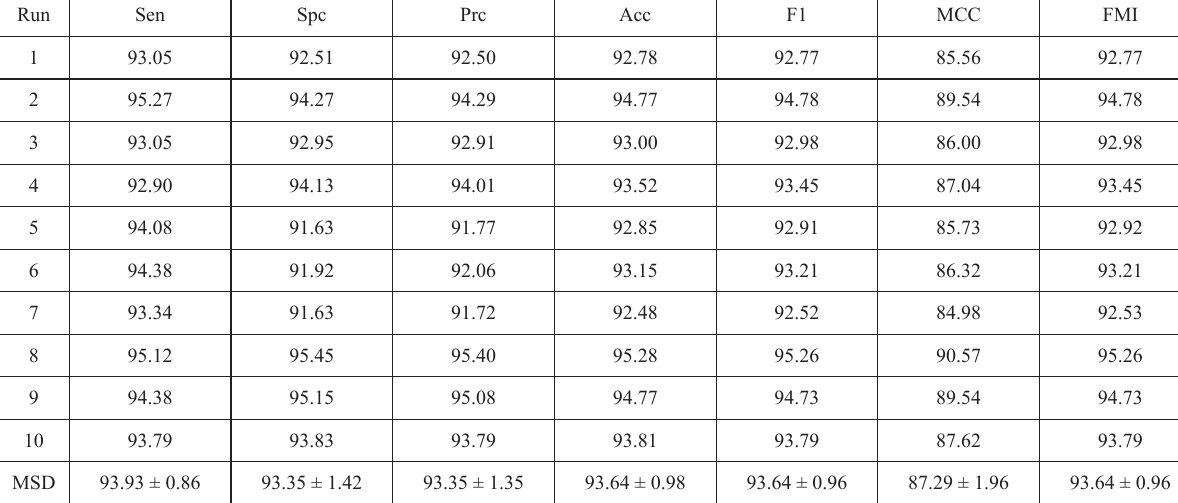
Table 8. Experimental results using average pooling.